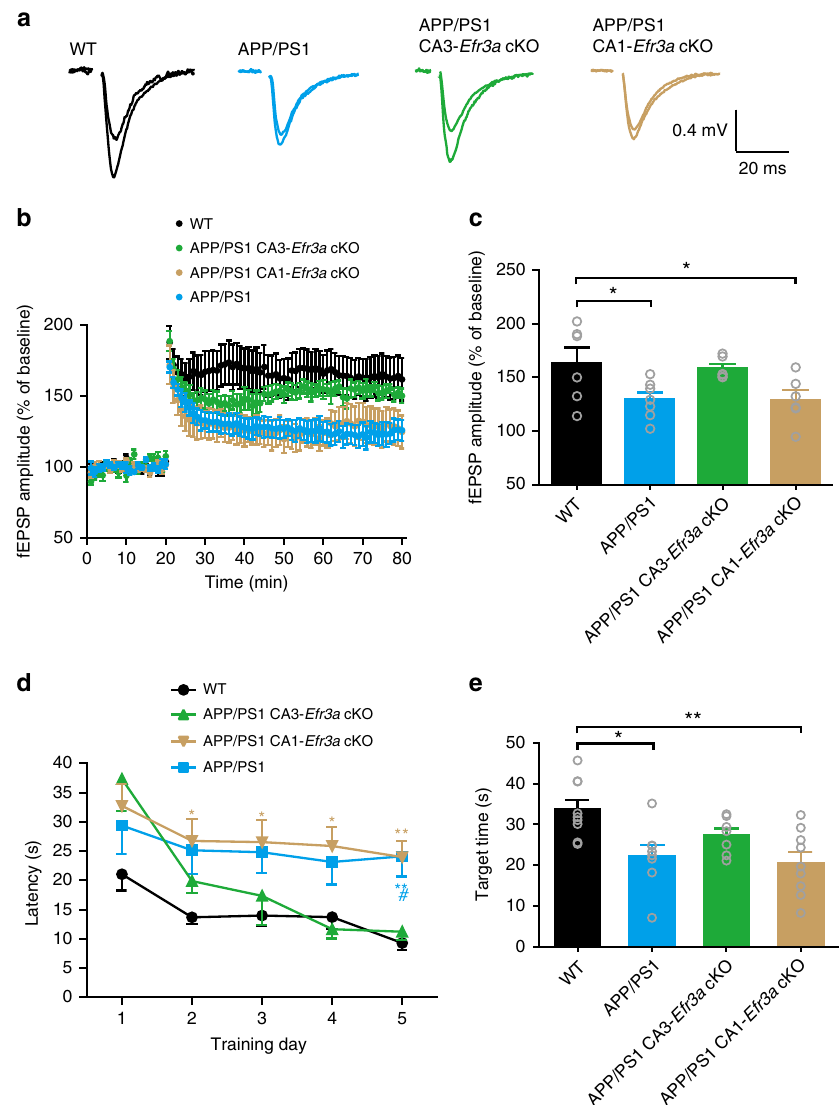
Fig. 10 Selectively knocking out Efr3a in the CA3 area ameliorates impairment in a presynaptically-expressed LTP at the SC-CA1 synapse and spatial learning and memory de fi cits in APP/PS1 mice. a Representative traces of averaged fEPSPs recorded in the CA1 area 10 min before and 50 min after high- frequency SC stimulation (superimposed) in WT, APP/PS1, APP/PS1 CA1- Efr3a cKO, and APP/PS1 CA3- Efr3a cKO mice. b Summary time course of the normalized amplitude of fEPSPs recorded from WT, APP/PS1, APP/PS1 CA1- Efr3a cKO, and APP/PS1 CA3- Efr3a cKO mice during an LTP